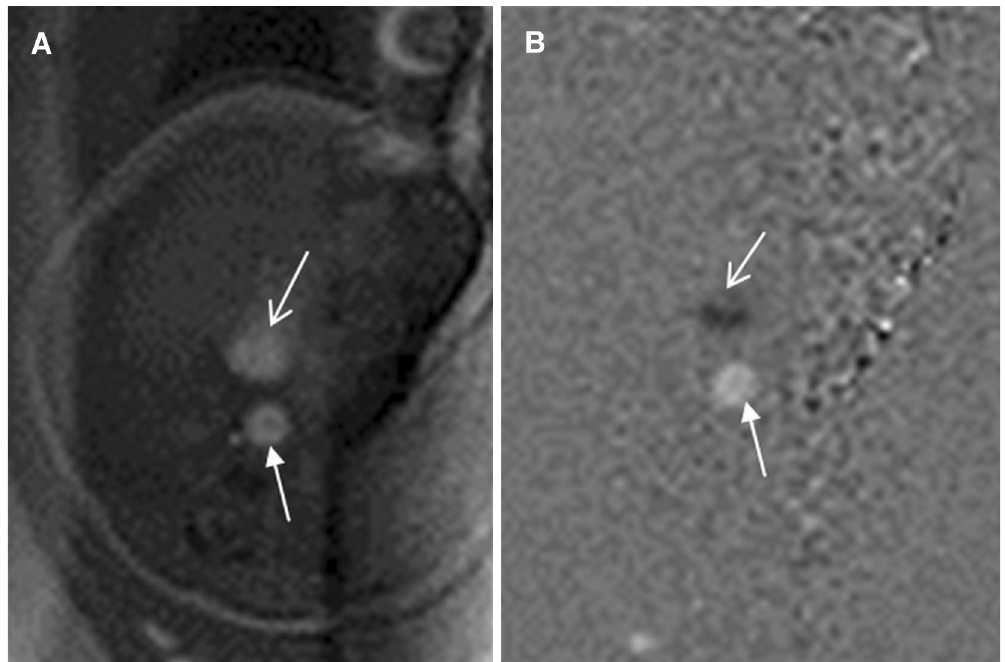
Figure 1. A 29-week-old foetus with a non-gated phase-contrast sequence. Foetal CMR non-gated phase- contrast sequence showing that the flow directions of the inferior vena cava (open arrows in A , B ; black in B ) and descending aorta are opposite (arrows in A , B ; white in B ).